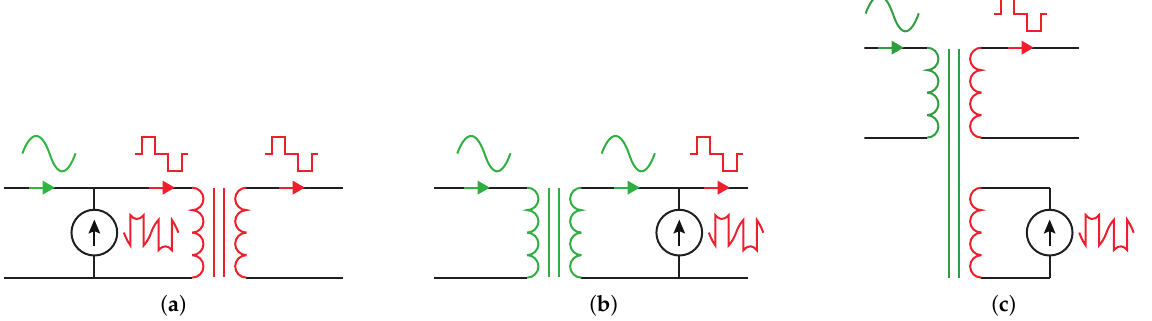
Figure 15. Shunt converter locations. ( a ) Primary-side. ( b ) Secondary-side. ( c ) Connected to an auxiliary